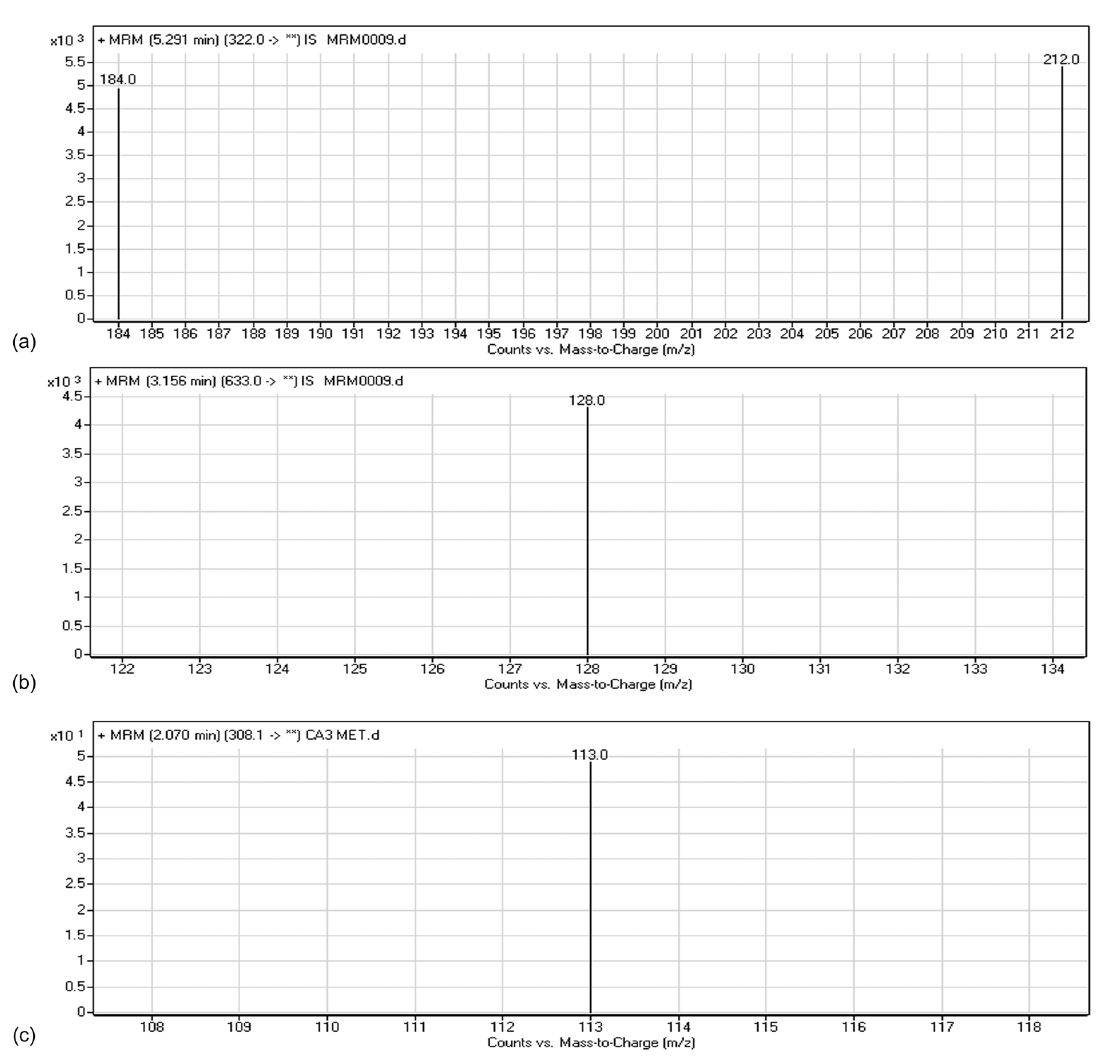
Figure 3: MRM mass spectral transitions of ( a ) CLOP, ( b ) FTB ( IS ) , and ( c ) CLOP